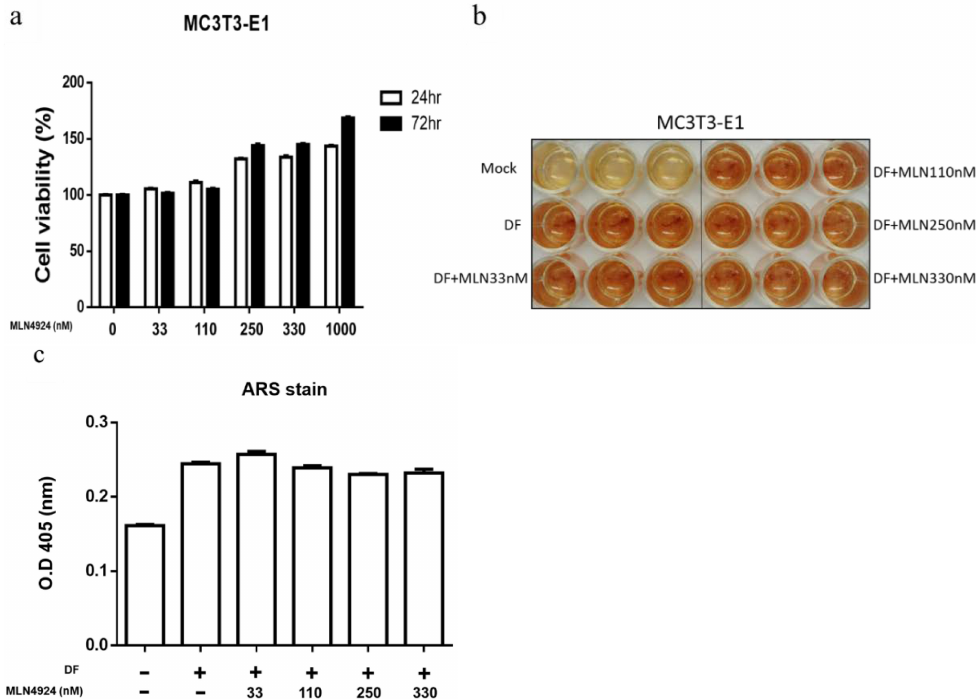
Figure 9. Effect of MLN4924 during osteogenesis. Mouse osteoblastic MC3T3-E1 cells were seeded in wells and incubated in osteoblast differentiation medium (DF), with or without various concentrations of MLN4924. After 21 days of differentiation, MC3T3-E1 cell viability was determined using crystal violet staining ( a ). Furthermore, the osteogenic differentiation of MC3T3-E1 cells was confirmed with Alizarin Red S staining ( b ). ( c ) The red-colored Alizarin-stained area was quantified on day